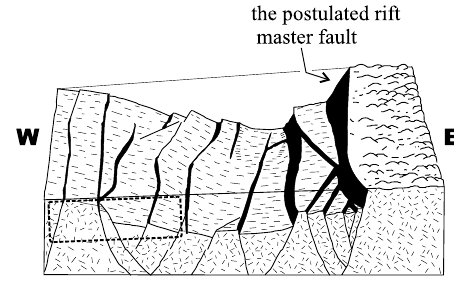
Fig. 5– Block-diagramshowingthearchitectureoftheEspinhaço rift, according to Martins-Neto (2000). Inset indicates the area where the synrift deposits occur with limited thickness in the western domain of the Serra do